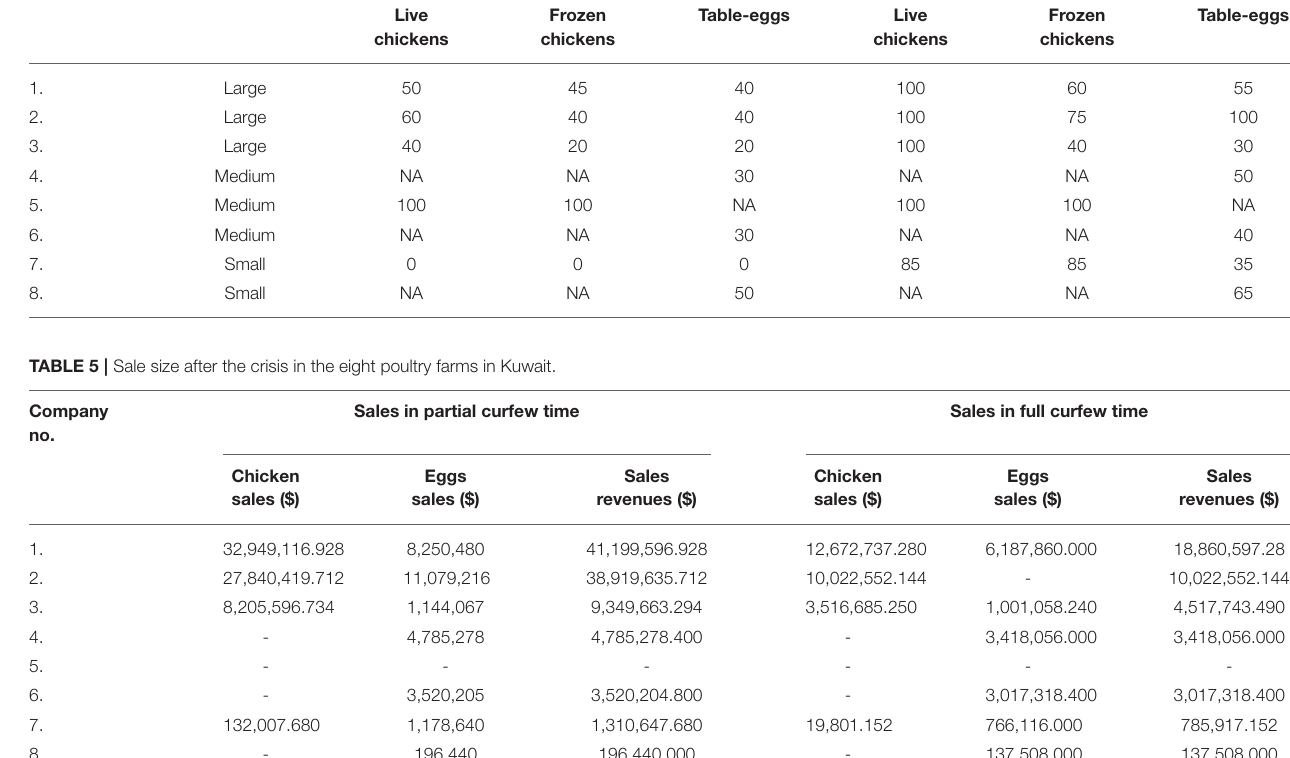
TABLE 4 | The effect of the crisis partial and full curfews on the sales loss of live and frozen broiler chickens and table-eggs. Company No.